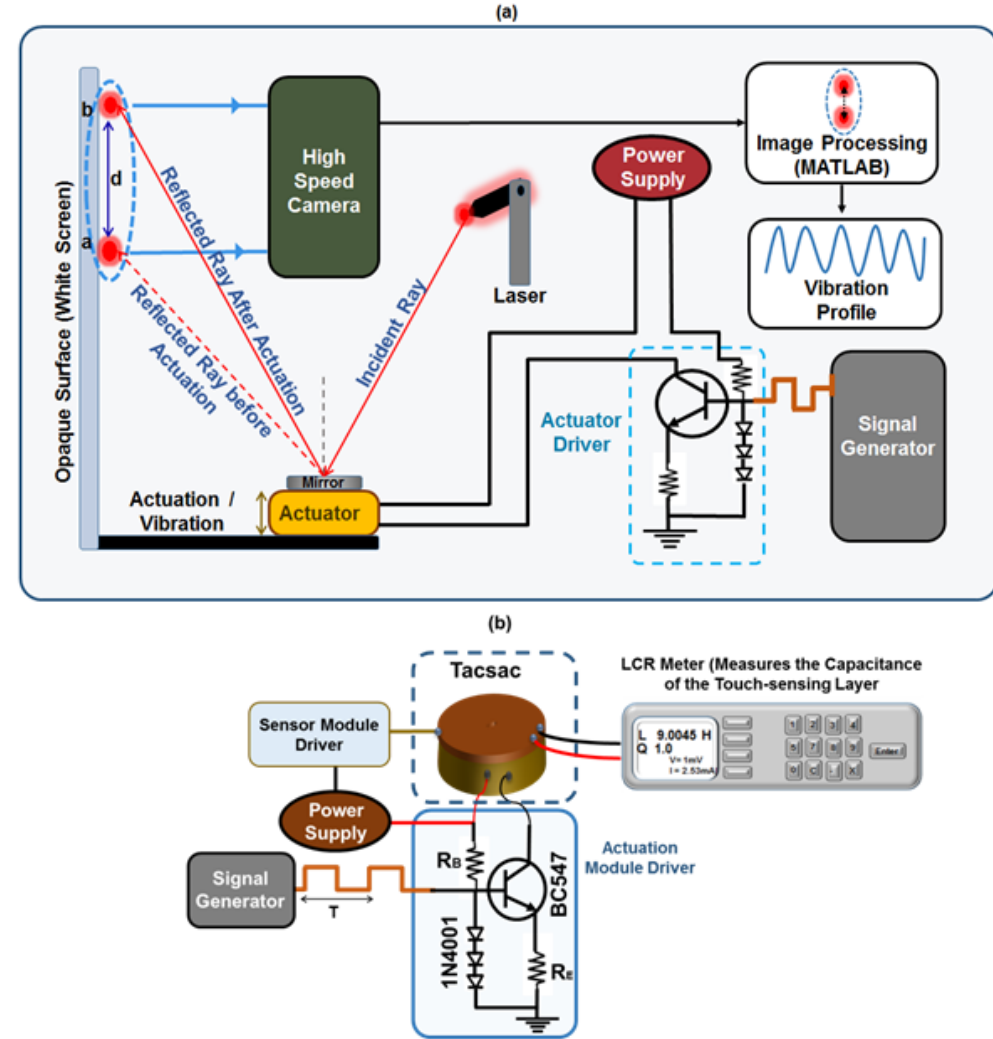
Figure 5. ( a ) Setup for Characterization of the Actuation Module ( b ) Setup for the characterization of sensing module of the fabricated Tacsac with and without actuation.